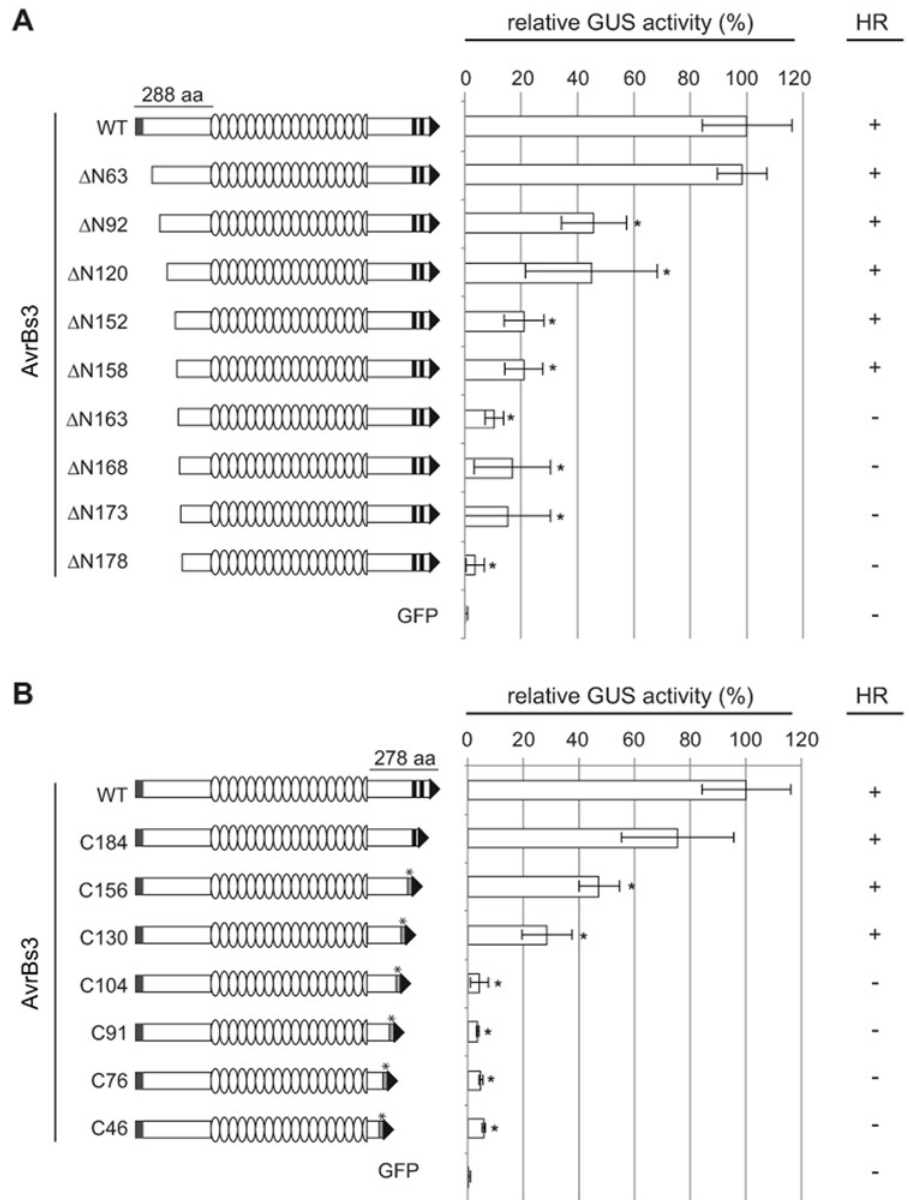
Fig 5. In planta activity of AvrBs3 N- and C-terminal deletion mutants. AvrBs3 and deletion derivatives were expressed in N . benthamiana leaves as 4× c-Myc fusions under control of the 35S promoter by Agrobacterium -mediated transformation. ( A ) N-terminal deletion constructs are schematically shown on the left and are named by the number of deleted amino acids. ( B ) Names of C-terminal deletion constructs indicate the number of amino acids remaining in the C-terminal part of AvrBs3. To compensate for the loss of NLSs and AD in CTR mutants the SV40 NLS and the AvrBs3 AD were added to the new C-termini. GUS activities were determined in N . benthamiana leaves three days after Agrobacterium -mediated co-delivery of the reporter construct ( UPA20 box-minimal p Bs4 driving a promoterless uidA [48]), the silencing inhibitor p19 , and avrBs3 , avrBs3 -derivatives or gfp (negative control). GUS activity induced by WT AvrBs3 was set to 100%. NTR box, T3S signal; CTR boxes, AvrBs3 NLSs; box with asterisk, SV40 NLS; arrow, AD. Error bars indicate SD. Asterisks indicate statistically significant differences to the GUS activity induced by WT AvrBs3 ( t -test, P < 0.05). The right column shows the HR induction by AvrBs3 and deletion derivatives in leaves of resistant pepper (ECW-30R) and Bs3 -transgenic N . benthamiana plants three days after Agrobacterium - mediated delivery of the avrBs3 or derivative constructs. The experiments were repeated three times with similar